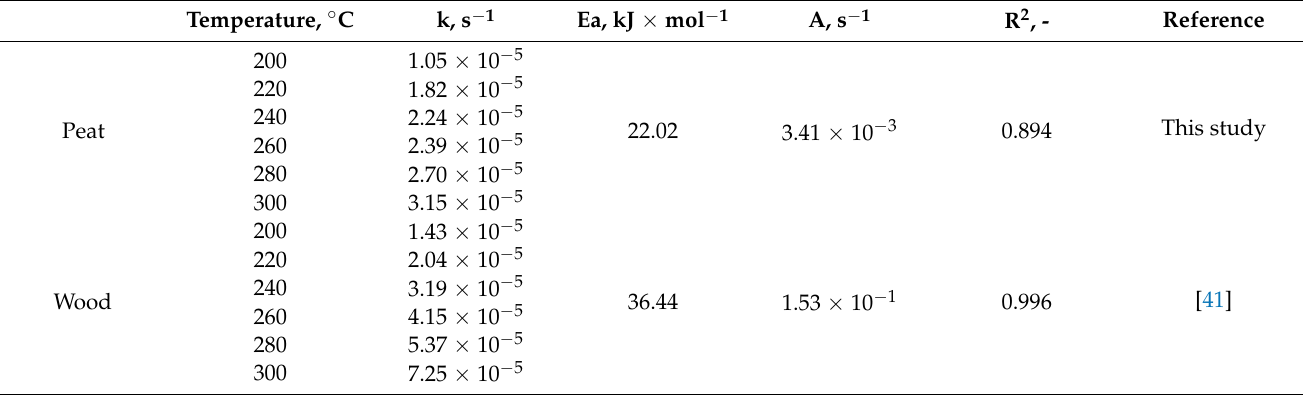
Table 3. Torrefaction kinetic triplets for isothermal conditions (T = 200–300 ◦ C, t = 60 min) considering a first-order reaction model.